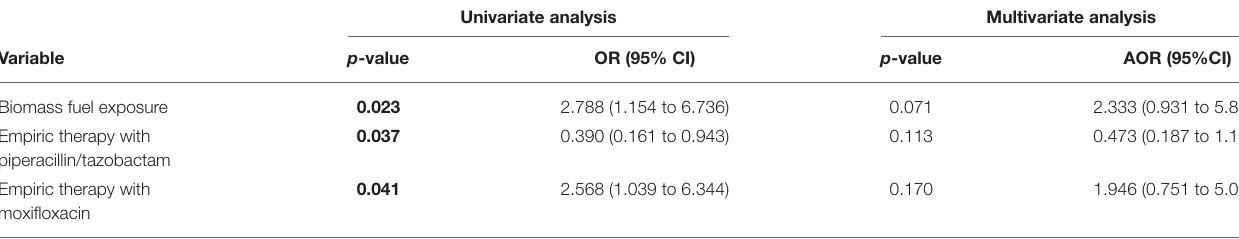
TABLE 7 | Factors associated with unsuccessful treatment outcome: multivariate binary logistic regression analysis. Univariate analysis